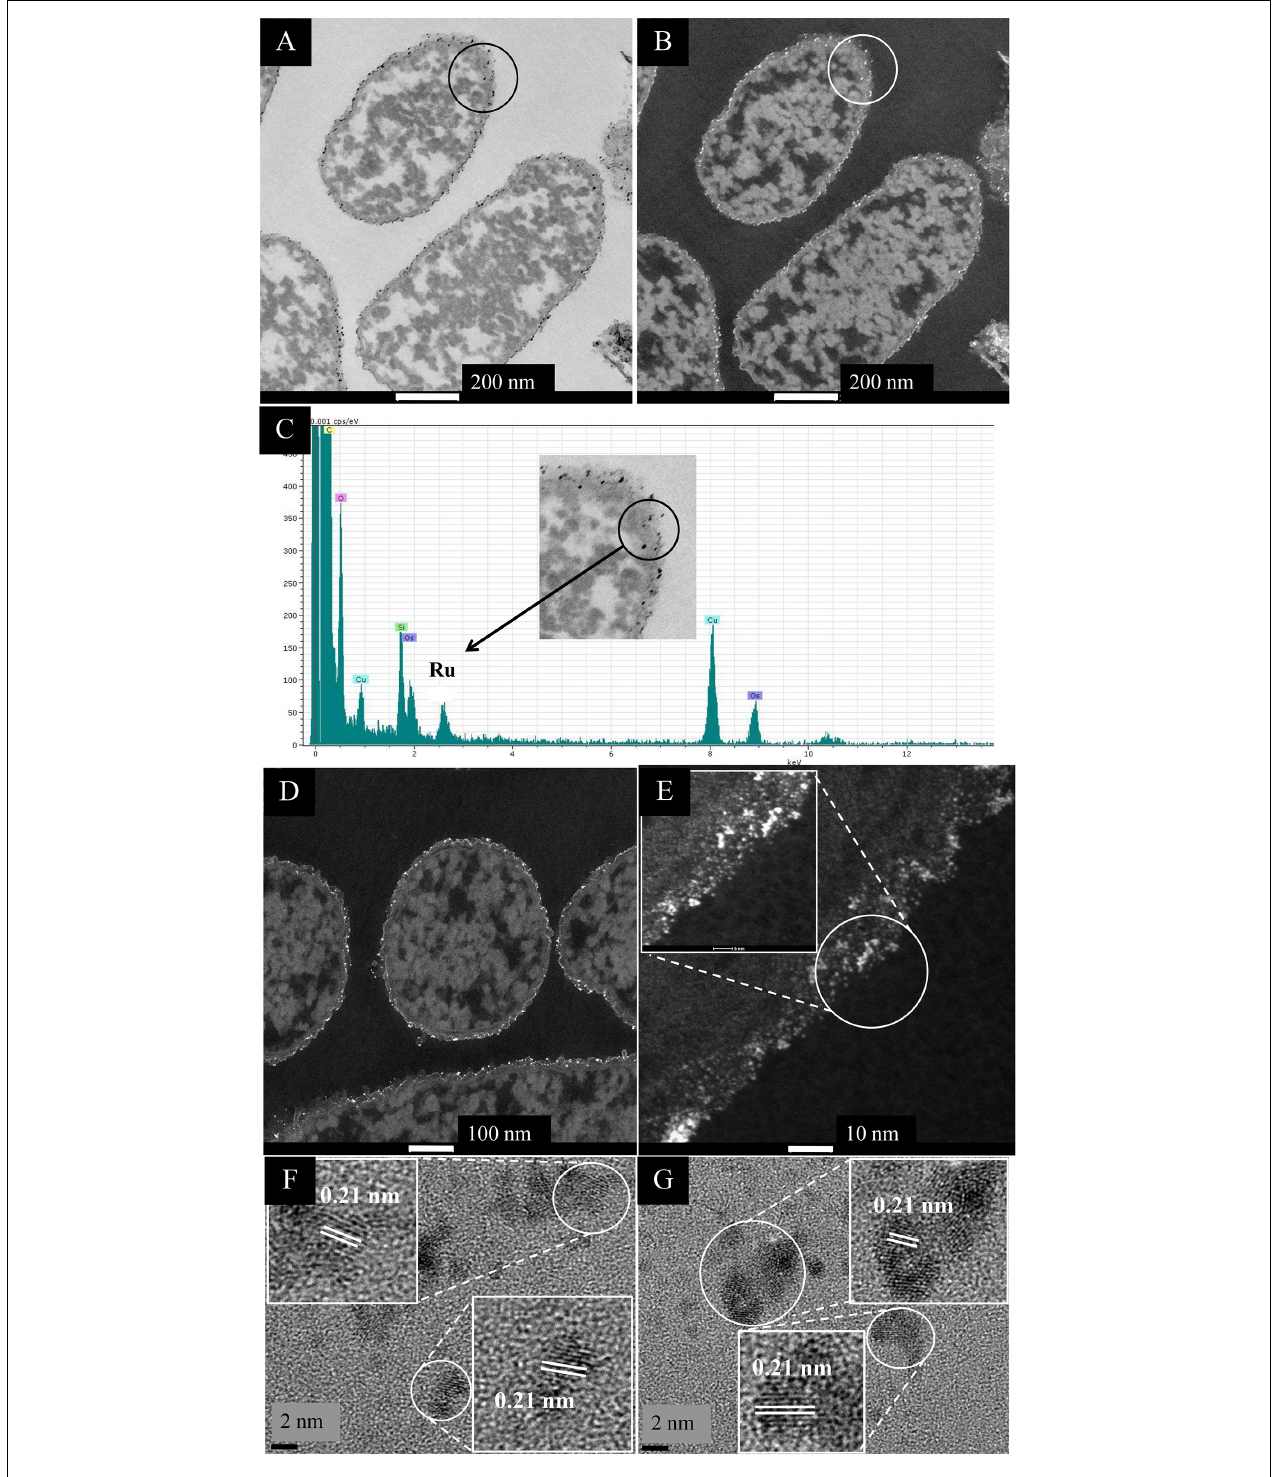
FIGURE 1 | EM study of E. coli MC4100 cells loaded to 2.6 wt% of Ru. (A,B) STEM/HAADF images of cell sections. For comparison cells with no added metal are shown in Supplementary Figure S2 . Magnification of the circled section (inset) shows the presence of nanoparticles located in the membrane ( C , inset.) EDX analysis confirmed the presence of Ru in the cell surface NPs (C) . Cu is from the EM grid and Os from the stain. Bars are 100 nm (A,B) . HAADF image is shown enlarged (D,E) revealing heterogeneity of Ru-NP sizes (E) and NP localization only in the periplasm (width of periplasm < 35 nm). HR-TEM analysis of the circled area in panel (E) revealed consistent lattice spacing of 0.21 nm (F,G) which can be attributed to either Ru metal or RuO 2 (see text).